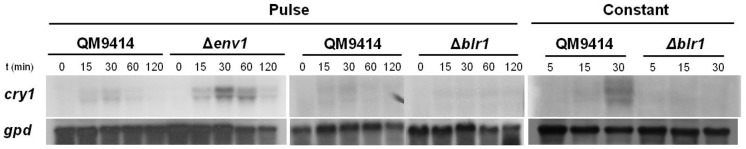
Expression of cry1 in response to blue light.Analysis of the expression of cry1 induced by a pulse of blue light (1200 µmol m−2) or upon exposure to constant light (fluence: 3.6 µmol m−2 s−1) for 72 h growth, as indicated. Transcript levels of the cry1 gene were determined by Northern blot analysis of the parental strain QM9414, Δenv1, Δblr1 strains. The gpd gene was used as loading control in the different conditions.